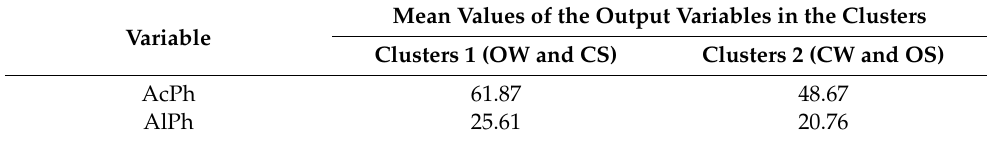
Table 11. Mean values of the output variables in the clusters. Mean Values of the Output Variables in the Variable